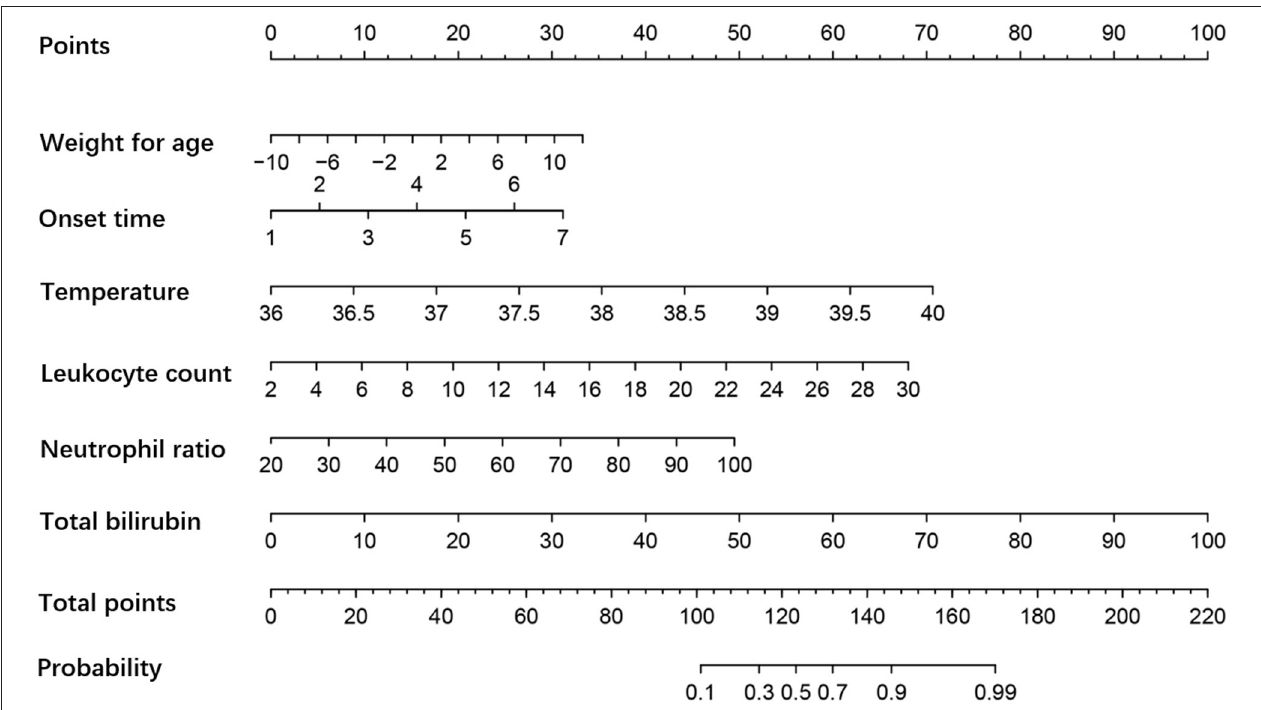
FIGURE 1 | Nomogram of the severity of appendicitis in young children. The influencing effects of factors are shown in appropriate scale. The sum of all scores indicates the probability of complicated appendicitis, and more points suggest a more severe appendicitis.